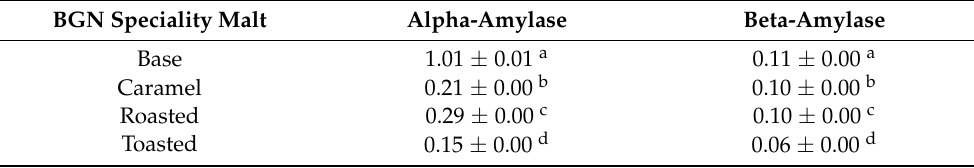
Table 4. Bambara groundnut specialty malts α and β -amylase activities 1